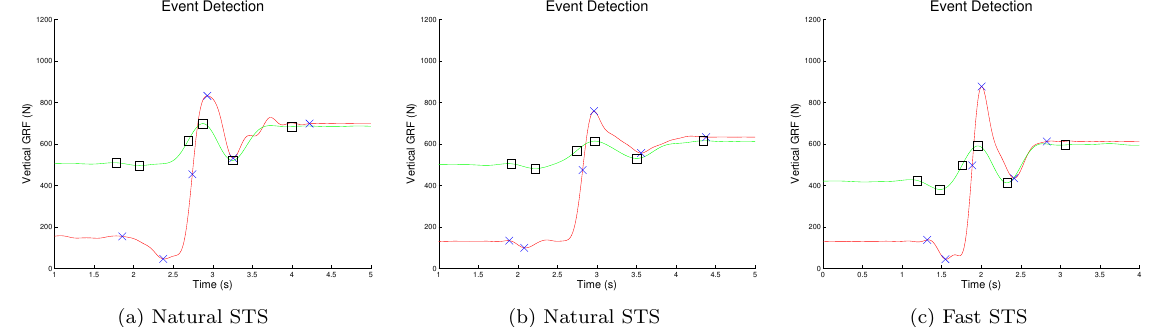
Figure 5: Ground reaction forces for STS at natural speed vs time for 3 users. The red line (blue Xs) denote the forces (events) from the force plate. The green line (black squares) denote the forces (events) computed via the dynamical model.